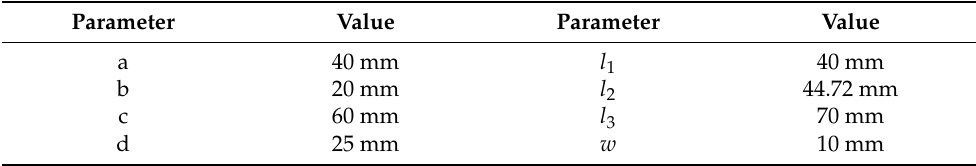
Table 2. Parameter values for the kinematic model of the gripper with underactuated